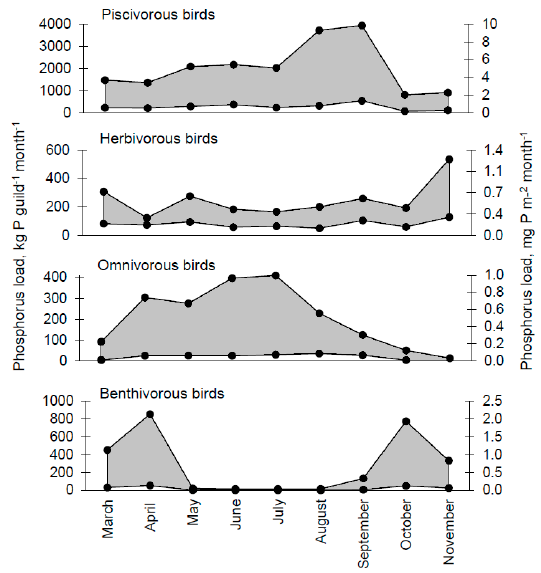
Figure 2. Monthly contributions of bird trophic groups to total avian P production in the Curonian Lagoon. Grey area represents ranges of possible loads. Note that the scales are different for the figures.